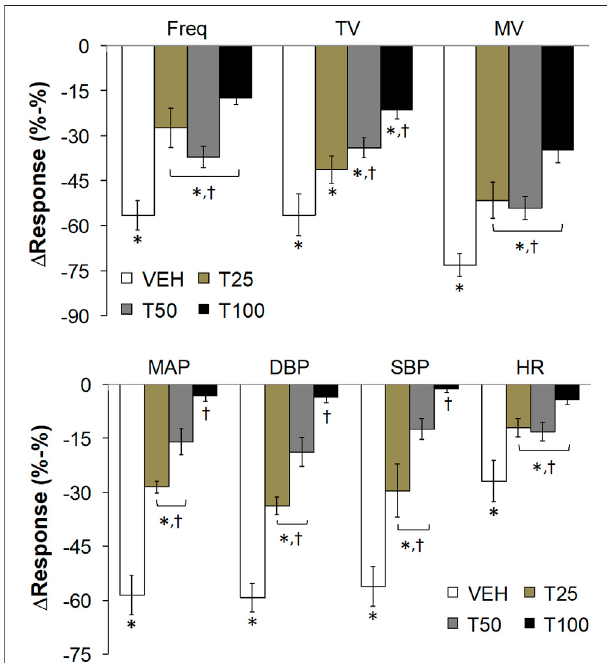
FIGURE 3 | The peak changes in ventilatory parameters (top panel) and cardiovascular parameters (bottom panel) elicited by bolus injections of vehicle (VEH) or Tempol (25, 50 or 100 mg/kg, IV, designated T25, T50 and T100) and subsequent injections of fentanyl (5 μ g/kg, IV) in iso fl urane- anesthetizedrats.Therewere12ratsinthevehiclegroup,and3,5and12rats in the 25, 50 and 100 mg/kg Tempol-treated groups, respectively. Data presented aremean ± SEM.* p < 0.05, signi fi cant change. † P < T25, T50and/ or T100 vs. vehicle.